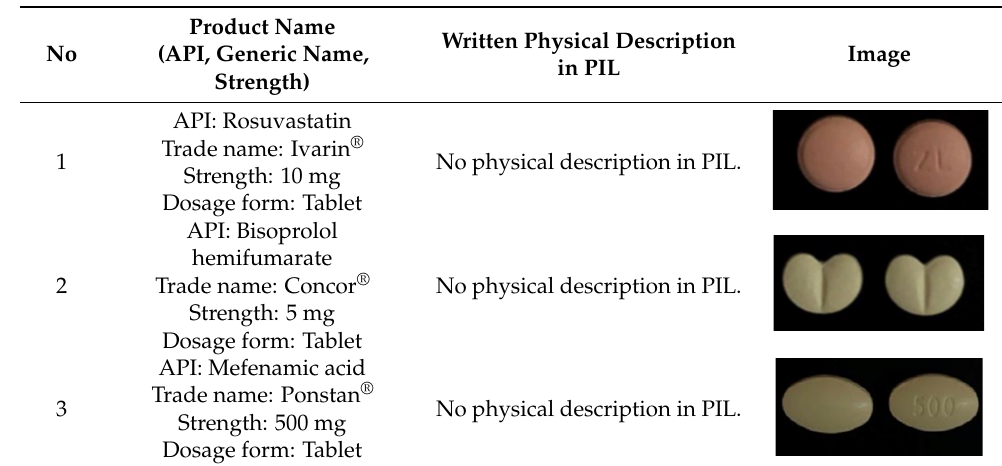
Table 5. Characteristics of pharmaceutical products that did not fulfill the GCC guidelines and matching.